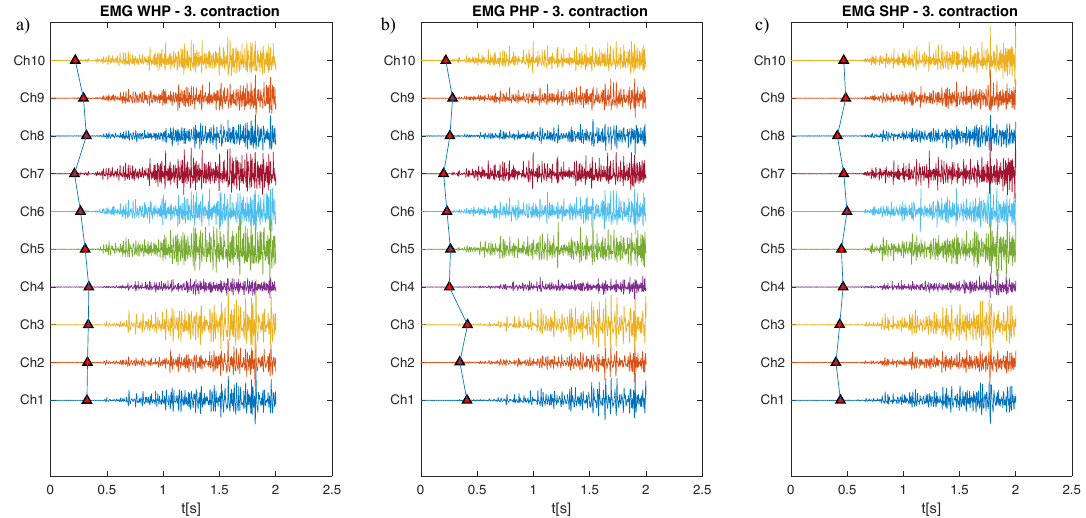
Figure 3. Example of start position of third contraction on the channel (Ch1-Ch4 vastus medialis, Ch5-Ch10 rectus femoris). ( a ) Start of contraction without using heel pad (WHP), ( b ) start of contraction with pronation heel pad (PHP), ( c ) start of contraction with supination heel pad (SHP). Red triangles represent the start of contraction. These point are linked by blue line for better visual evaluation.